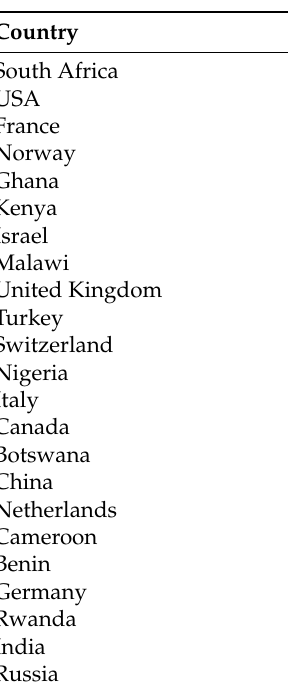
Table 5. Most cited